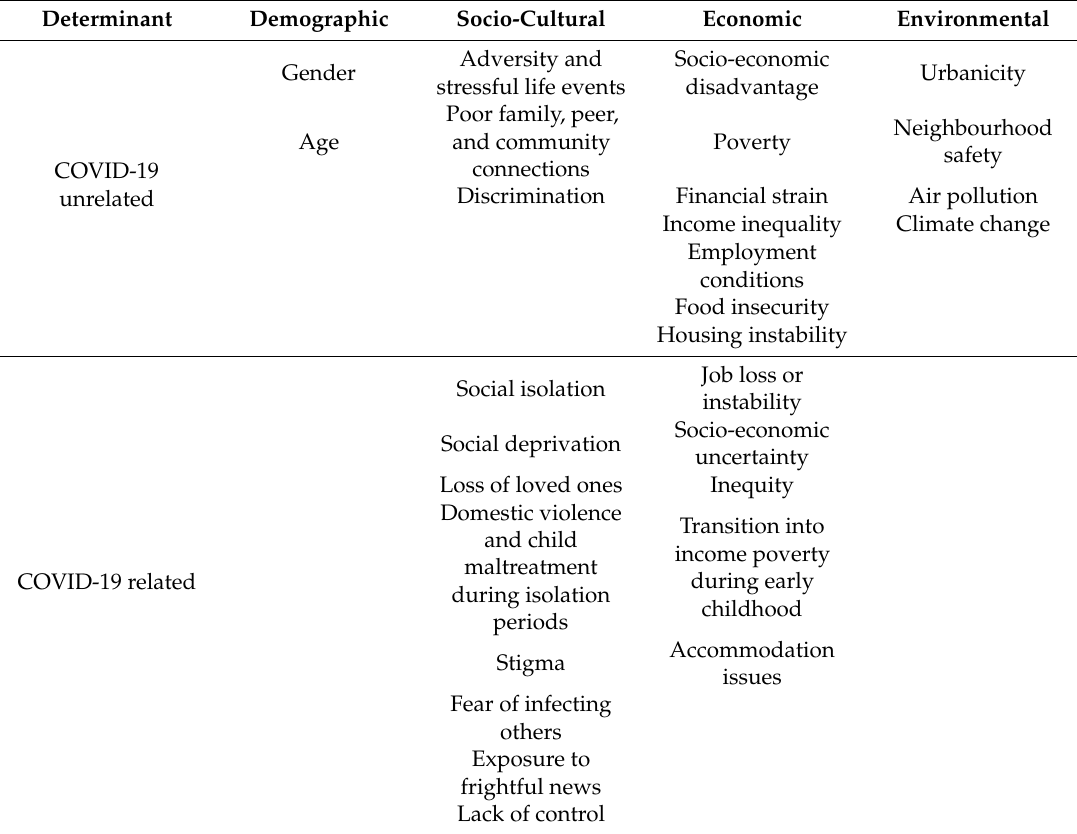
Table 1. Main non-biological determinants of mental health